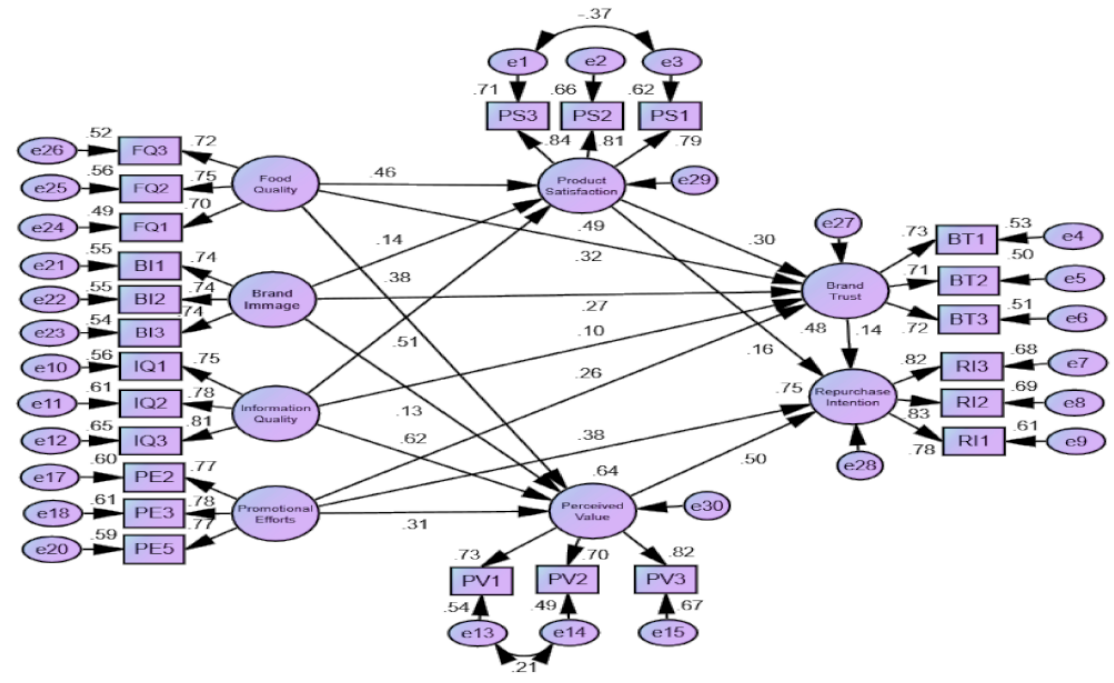
Figure 2. Structural